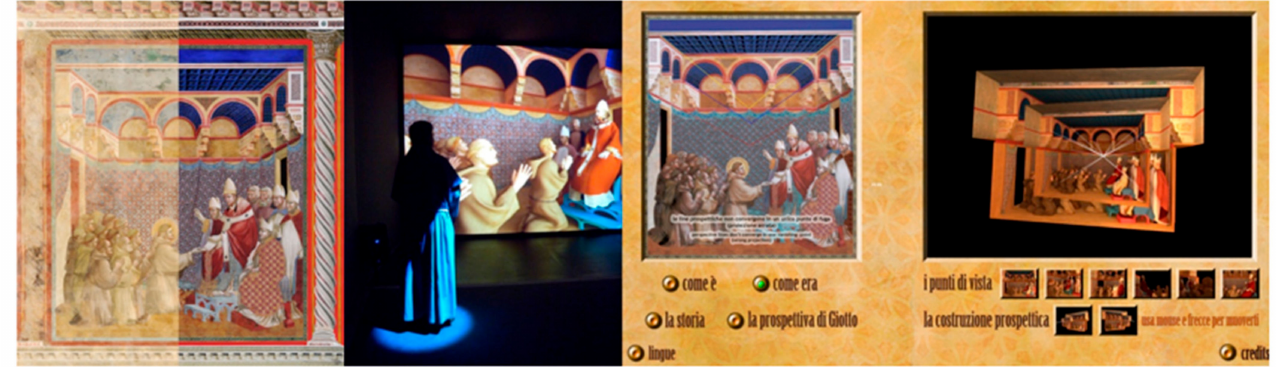
Figure 5. Giotto’s original painting “The Rule Confirmation”, its virtual restoration and three-dimensional